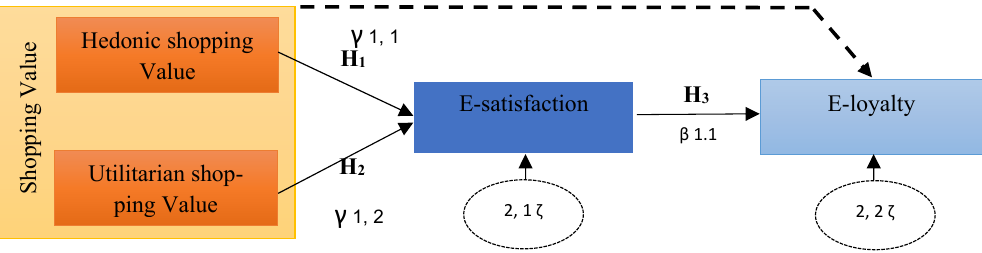
Fig. 1 . Conceptual framework and